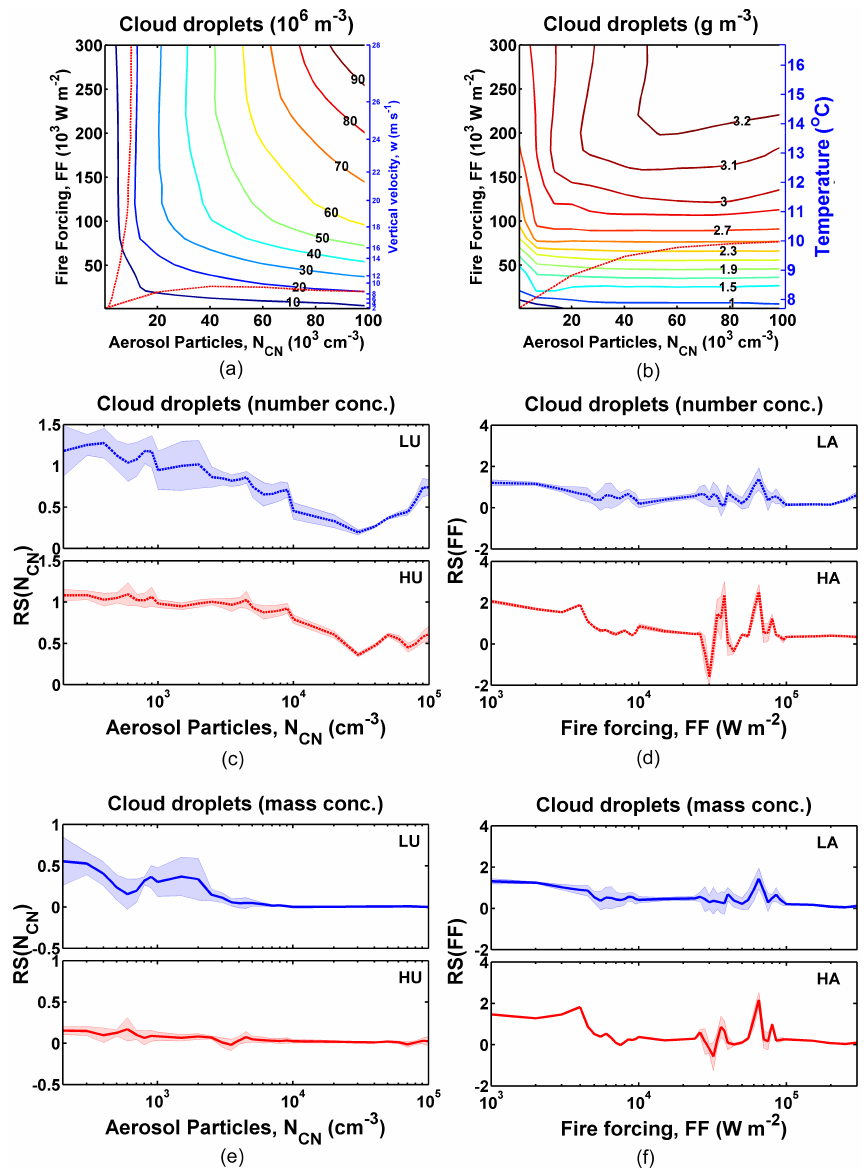
Figure 7. Number (a) and mass concentration (b) of cloud droplets calculated as a function of aerosol number concentration ( N CN ) and updraft velocity (represented by FF). Red dashed lines indicate the borders between different regimes defined by RS ( N CN ) / RS(FF) = 4 or 0.25. Relative sensitivities with respect to N CN (left) and FF (right) for number (panels c and d ) and mass (panels e and f ) concentration of cloud droplets under different conditions. The thick dashed or solid lines represent the mean values under a given condition, and the shaded areas represent the variability of estimation ( ± 0.5 σ ). Abbreviations are as follows: LU, low updrafts (1000–7000Wm − 2 ); HU, high